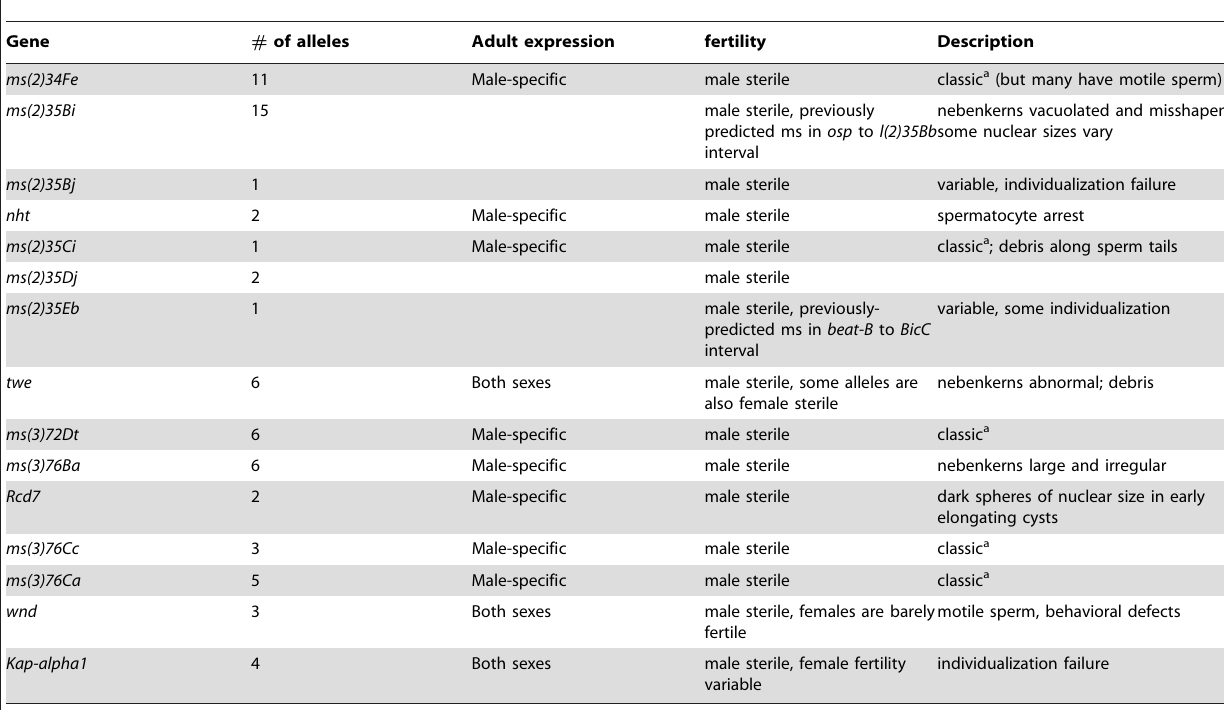
Table 2. Fertility genes identified by male-sterile mutations from the Zuker collection.